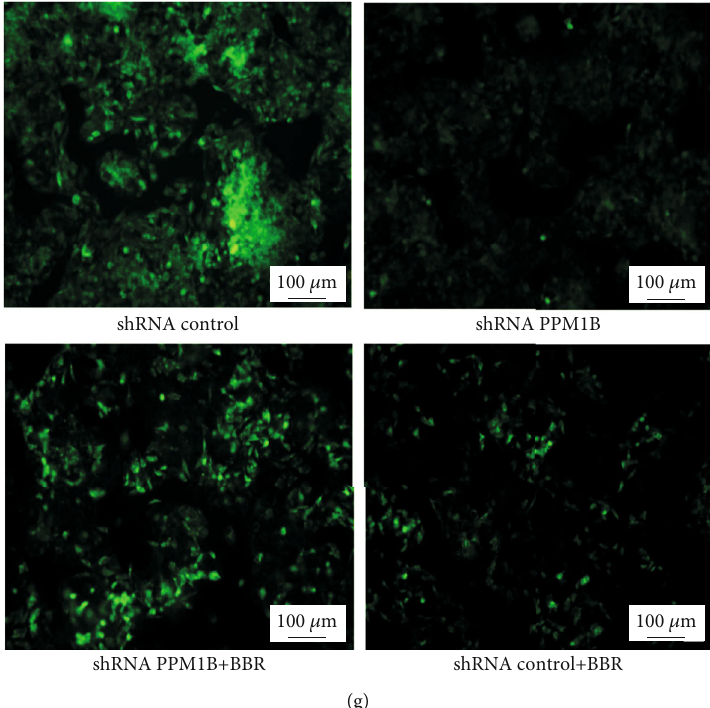
Figure 10: Silenced PPM1B promoted glucose consumption and in fl ammatory cytokine levels and weakened glucose uptake capacity in HepG2-IR cells. (a) Glucose consumption of unit cell. (b) TNF- α levels. (c) IL-6 levels. (d) IL-1B levels. (e) IL-8 levels. (f) IL10 levels. (g) 2-NBDG uptake (2-(N-(7-nitrobenz-2-oxa-1,3-diazol-4-yl)amino)-2-deoxyglucose). The data are presented as mean ± SD of three independent experiments. ▲ P < 0 : 05 and ▲▲ P < 0 : 01 , shRNA control group vs. shRNA PPM1B group; ∗ P < 0 : 05 and ∗∗ P < 0 : 01 , shRNA PPM1B+BBR group vs. shRNA PPM1B group; # P < 0 : 05 and ## P < 0 : 01 , shRNA control+BBR group vs. shRNA control group. Magni fi cation, × 100. Scale bar, 100 μ